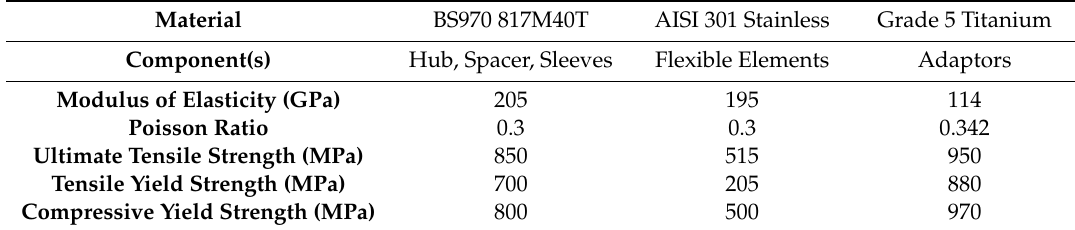
Table 1. Material properties.